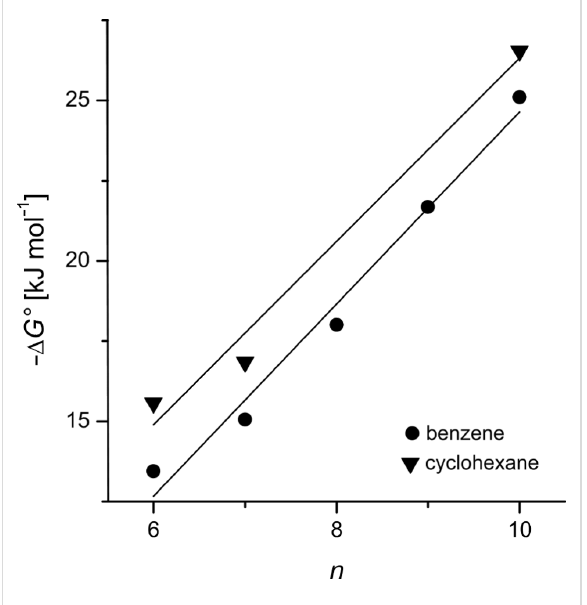
Figure 4: Gibbs free energy of formation of the inclusion compound of benzene derivatives, and cyclohexane derivatives in host 4 as a func- tion of the total number of carbon atoms of the guest n .